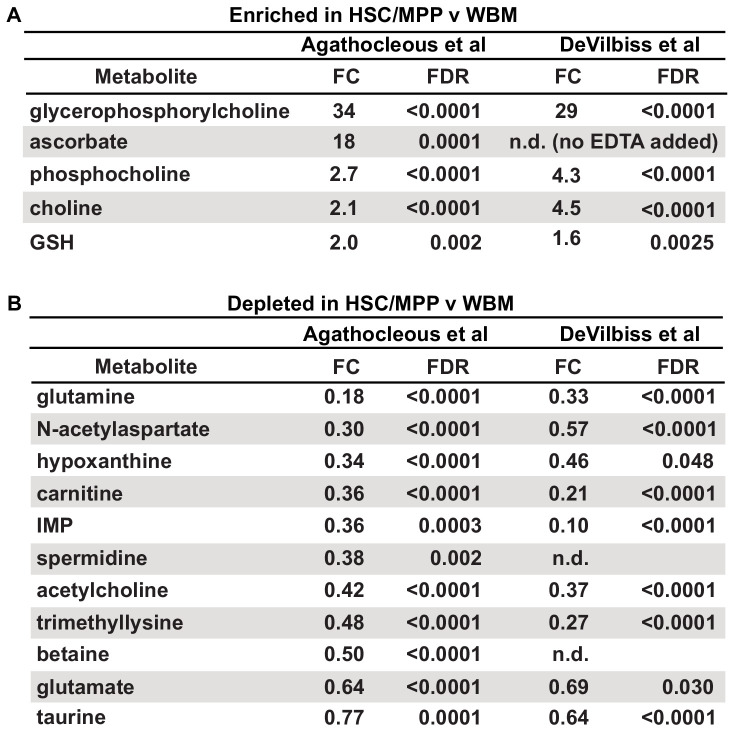
Metabolites that were detected as differing between hematopoietic stem cells (HSCs)/multipotent progenitors (MPPs) and whole bone marrow (WBM) cells using the Agathocleous et al.'s method (Agathocleous et al., 2017) versus the method described in this study.Metabolites identified by Agathocleous et al. as (A) enriched or (B) depleted in HSC/MPPs as compared to WBM cells and the results obtained for the same metabolites in the current study (data are from Figure 2).